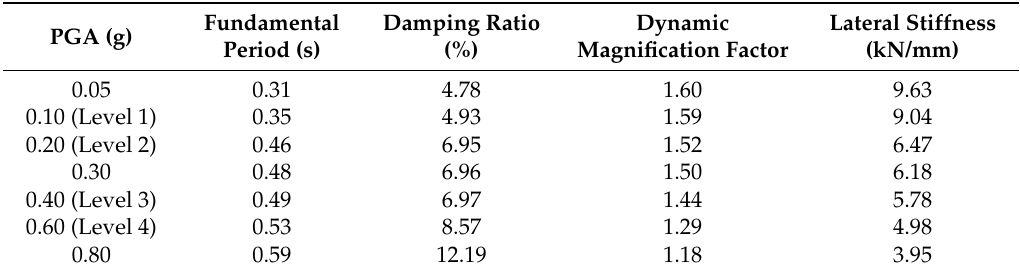
Table 5. Dynamic characteristic parameters and lateral stiffness of the specimen subjected to different PGAs.